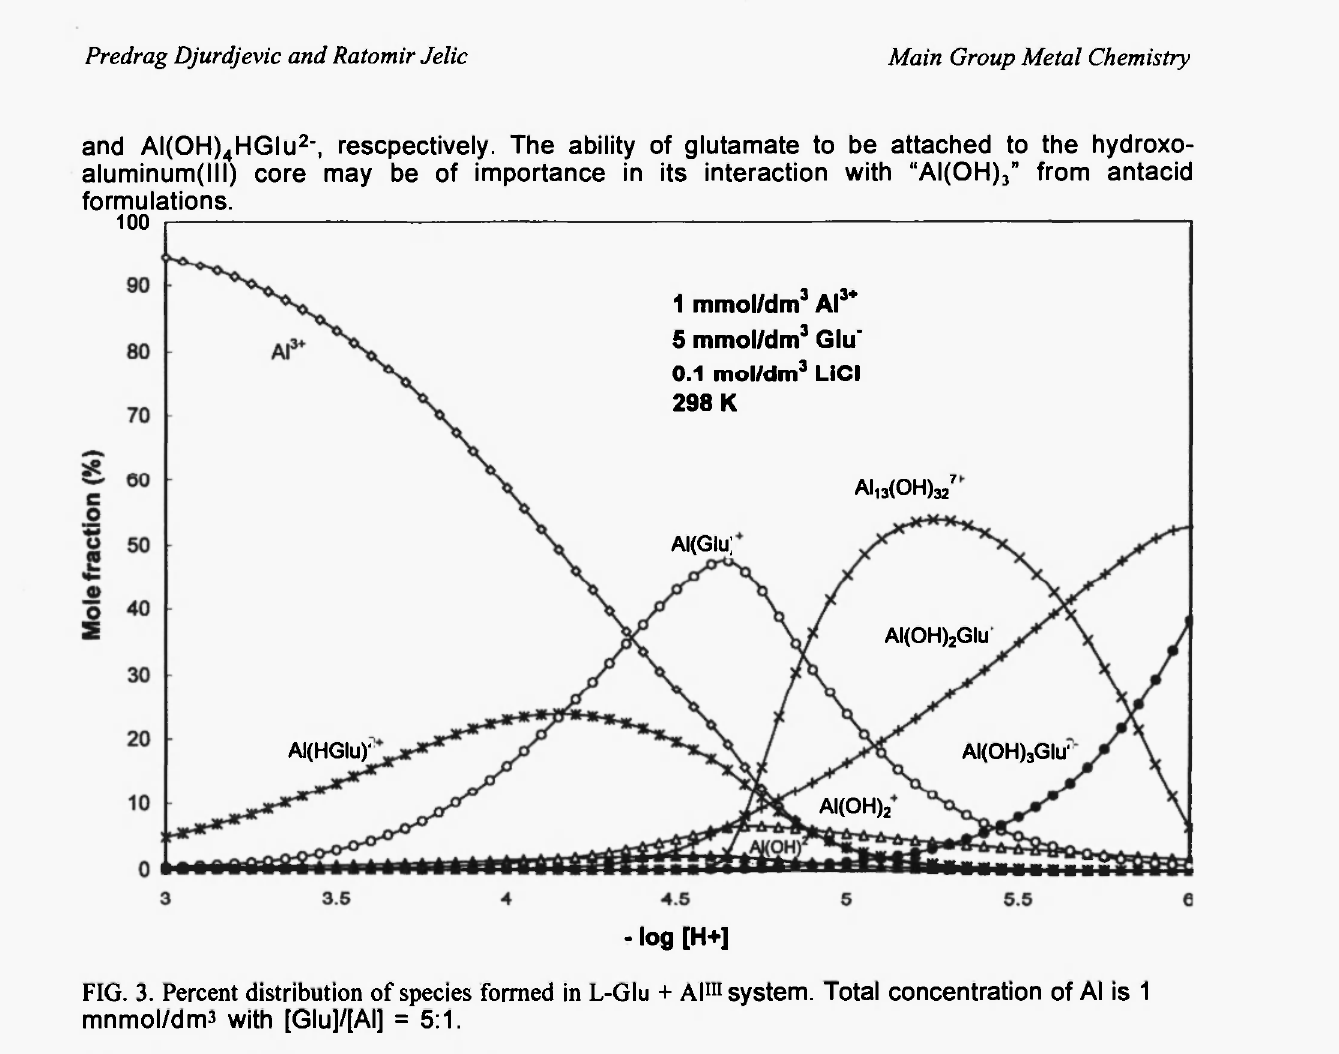
FIG. 3. Percent distribution of species formed in L-Glu + Al 111 system. Total concentration of Al is 1 mnmol/dm 3 with [Glu]/[AI] =